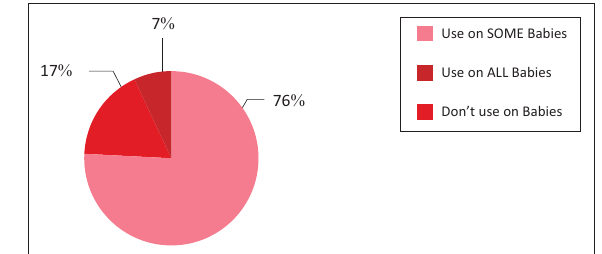
FIGURE 1: Otoscope usage on children below 5 years of